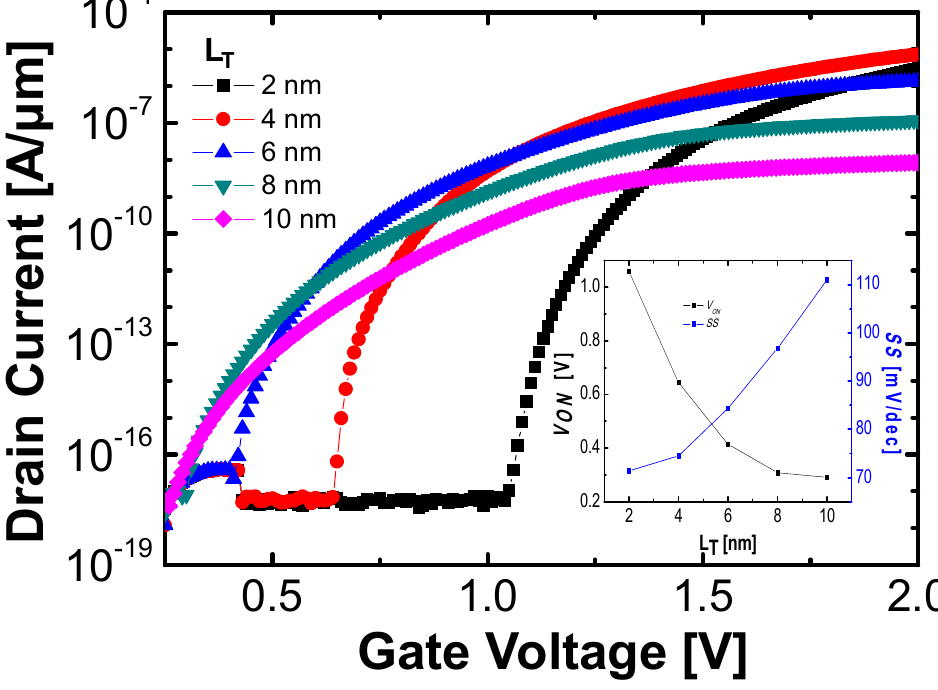
Figure 2. Log scale transfer characteristics with various L T at 0.7 V-drain voltage ( V DS ). The inset figure shows turn-on voltage ( V ON ) and average SS ( SS AVG ) which is extracted by measuring SS from V ON to V ON + 0.7 V.